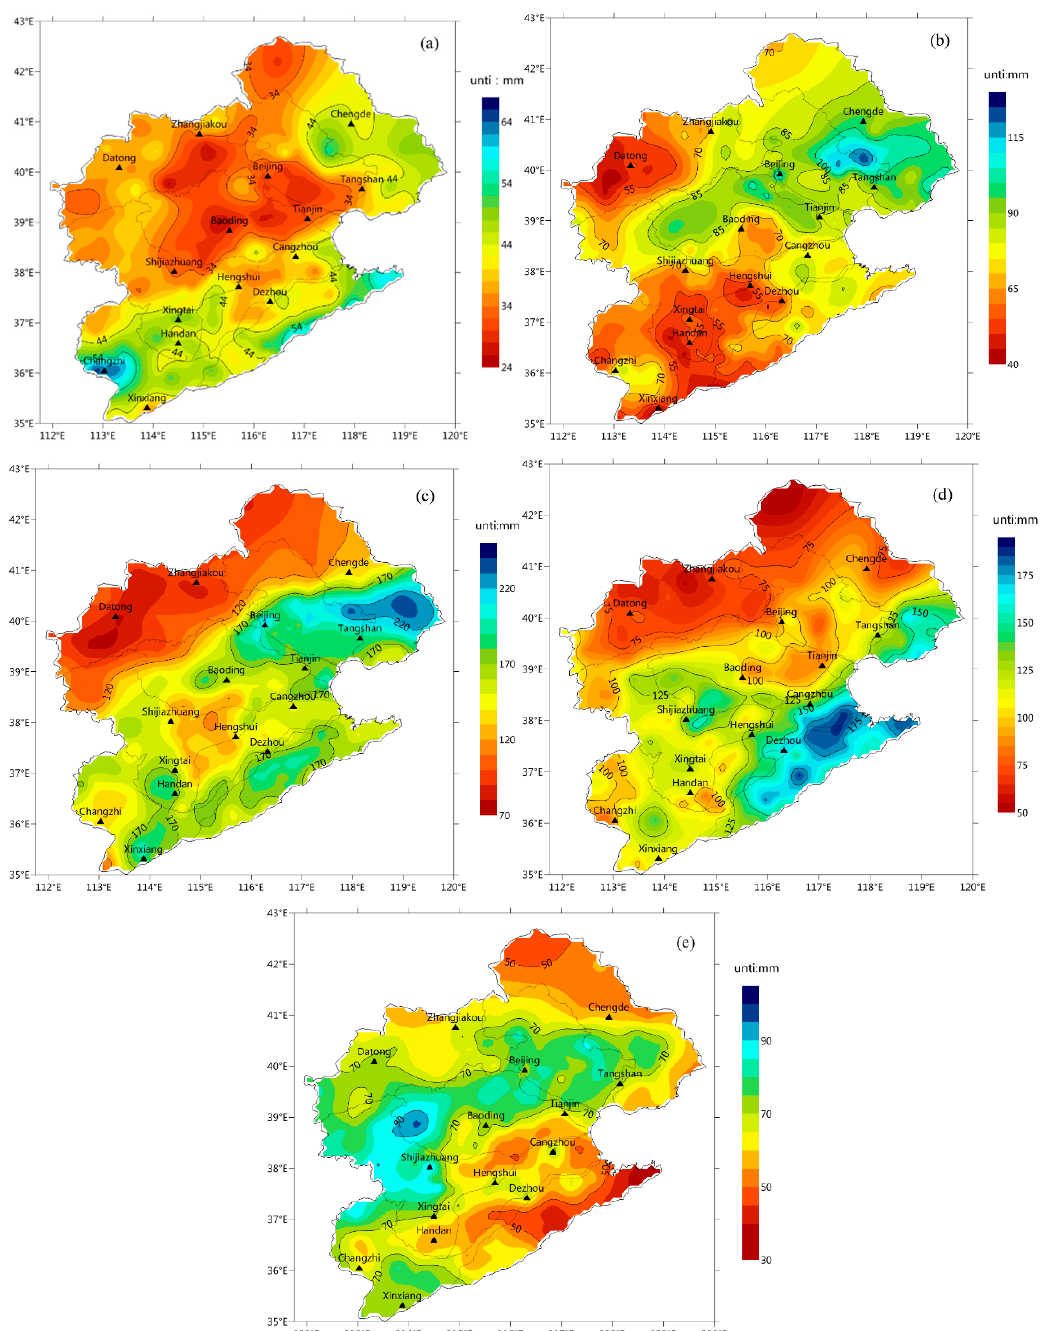
Figure 3. The spatial distribution of the monthly total precipitation in the Haihe River basin, 2007–2017 (unit: mm) (( a ), ( b ), ( c ), ( d ) and ( e ) for May, June, July, August and September,